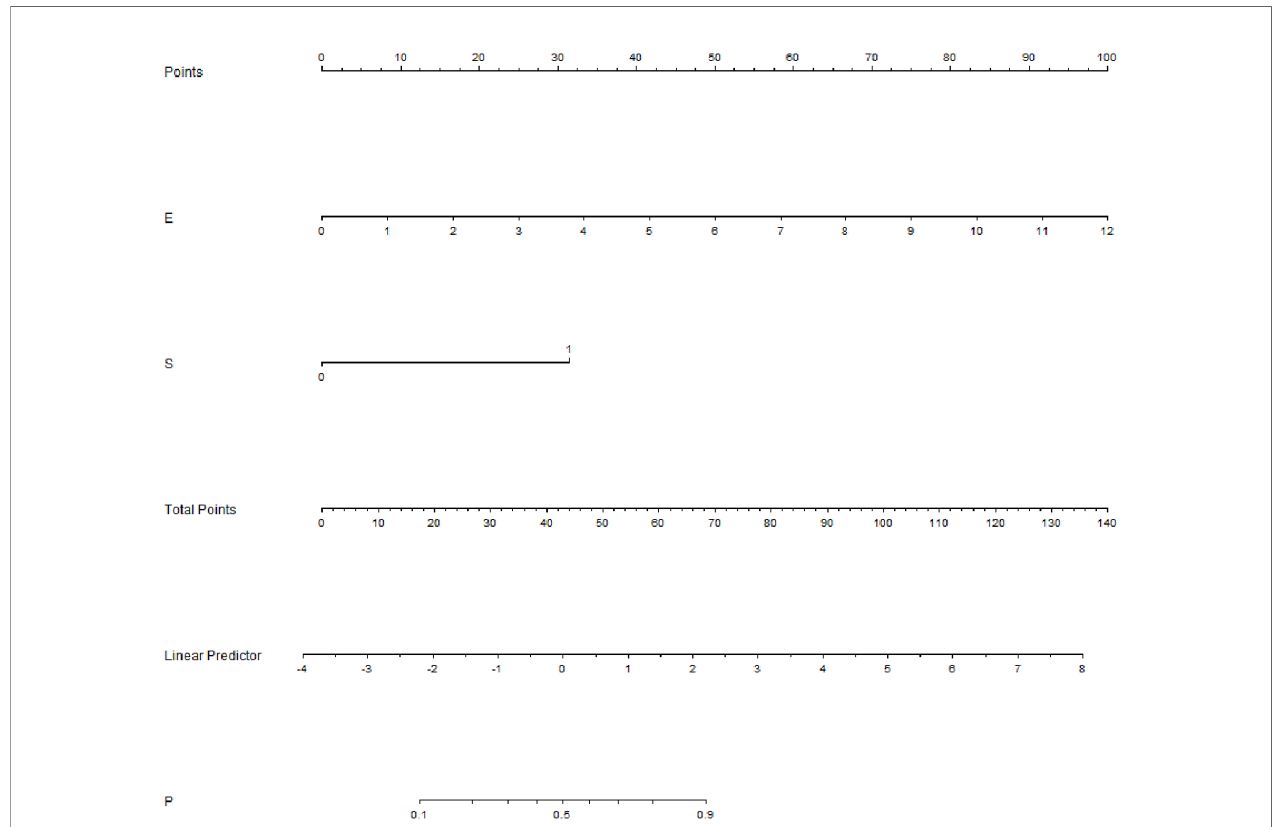
FIGURE 3 | Nomogram of combined diagnosis. E, elastography; strain ratio (SR) value; S, S-Detect result; P, predictive percentage.